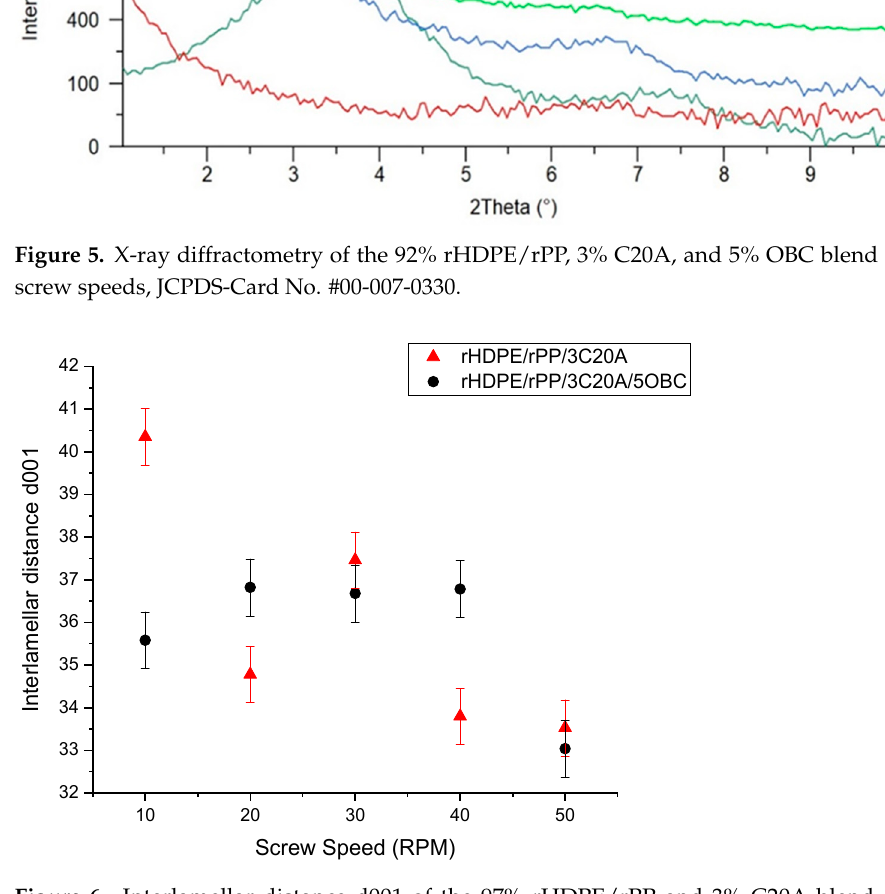
Figure 6. Interlamellar distance d001 of the 97% rHDPE/rPP and 3% C20A blend at different screw speeds.